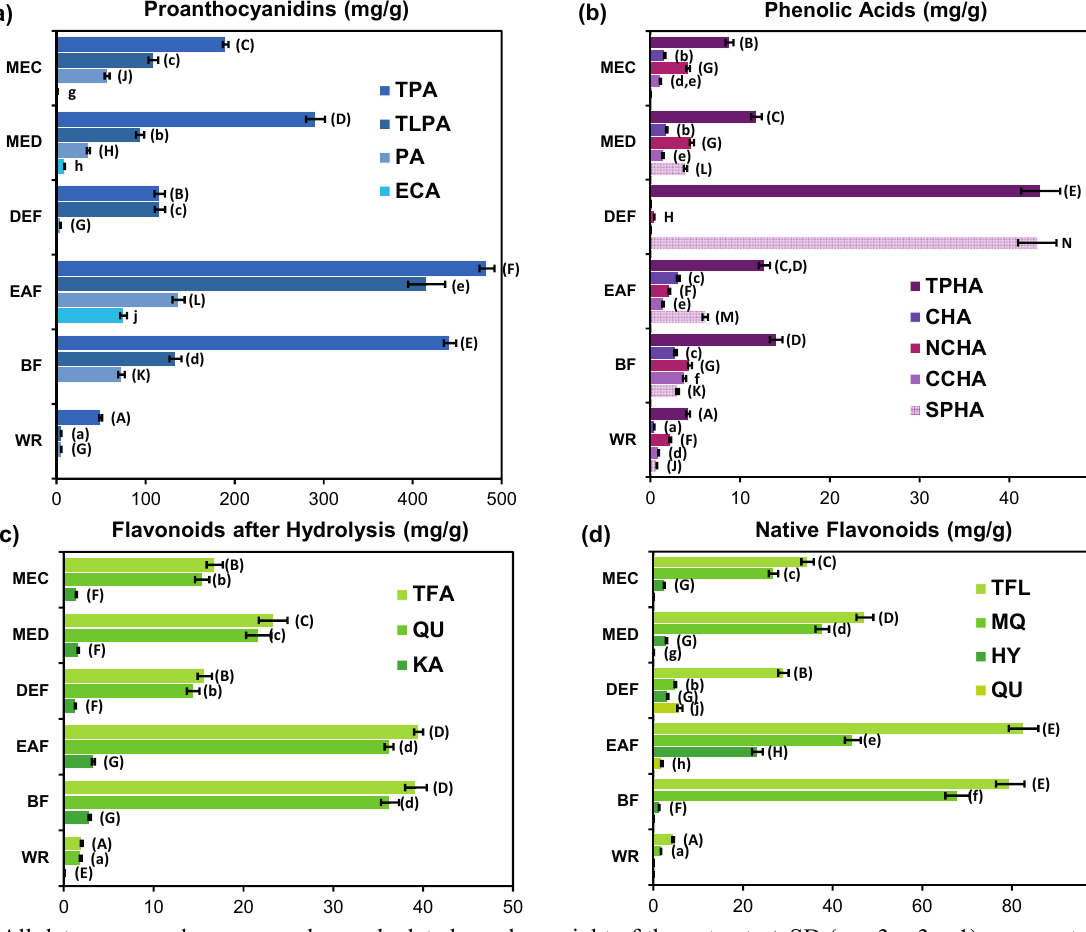
All data expressed as mean values calculated per dry weight of the extracts ± SD ( n = 3 × 3 × 1) represented by error bars. For each parameter different letters in parentheses indicate significant differences ( p <